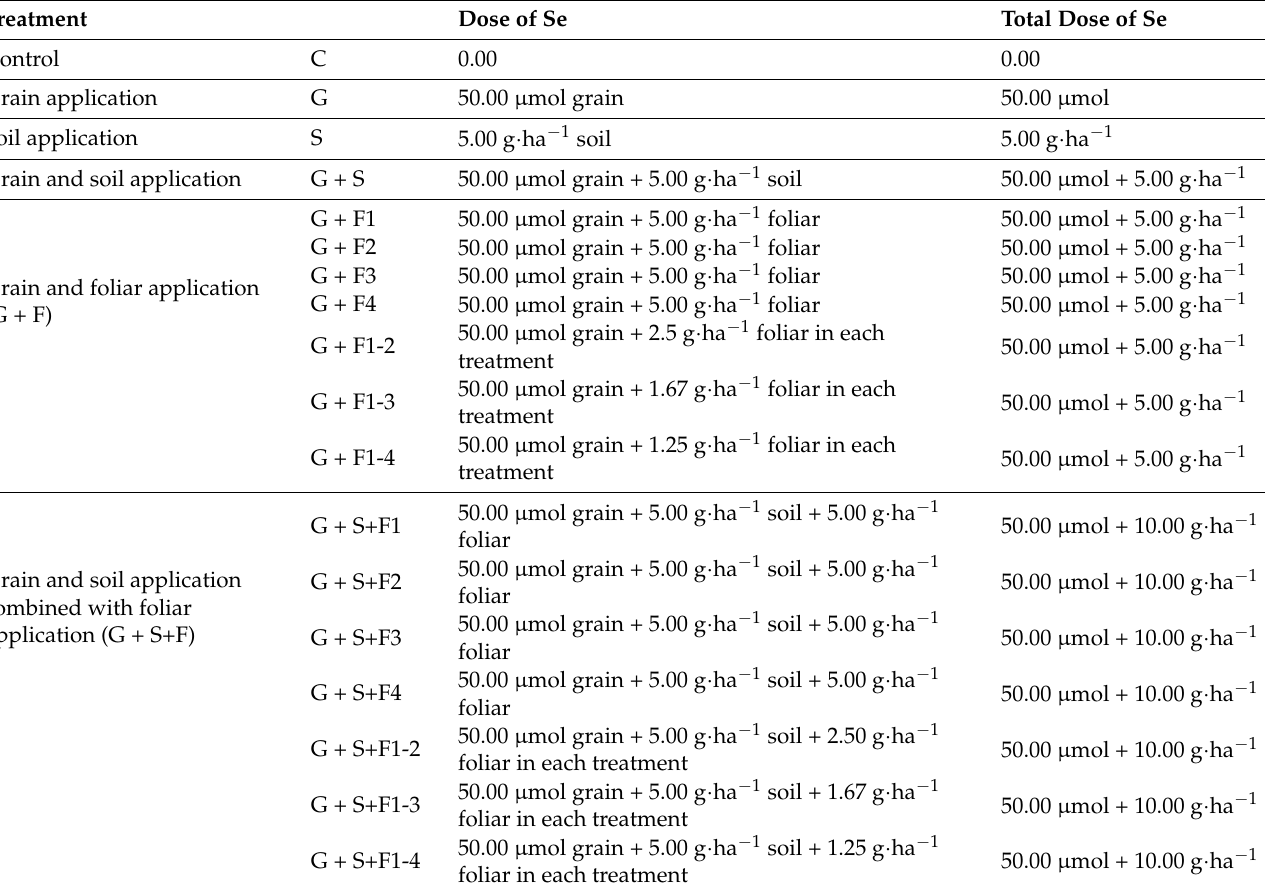
Table 2. Research